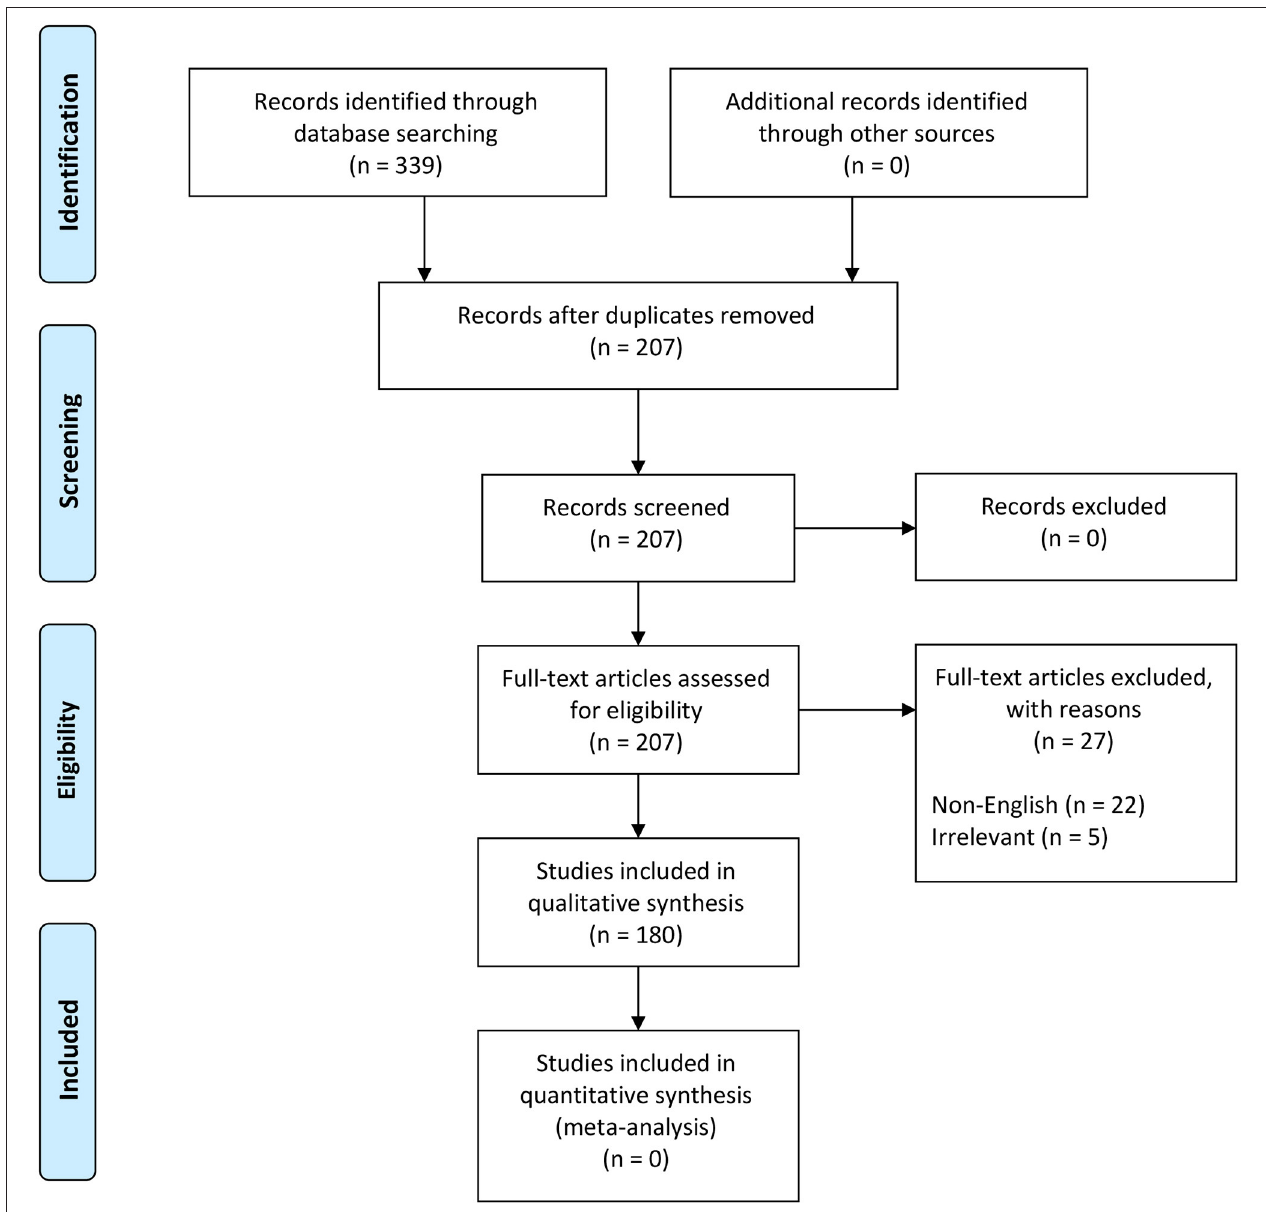
FIGURE 2 | PRISMA flow diagram detailing the literature selection process